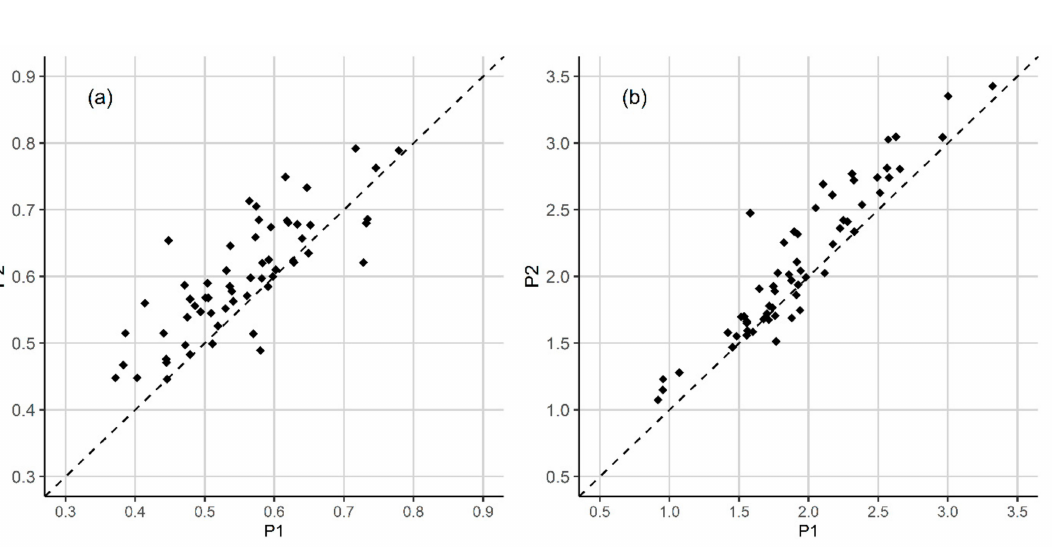
Figure 2. Changes in ( a ) Evenness—E and ( b ) Shannon diversity index—H’ between the two monitoring periods; P1: years 2004 / 2005, P2: years 2014 / 2015. Each data point indicates a sampling plot. Points above the dashed line (slope = 1) indicate plots with increased E (H’) value, and points under the line indicate plots with a decreased E (H’) value from period P1 to